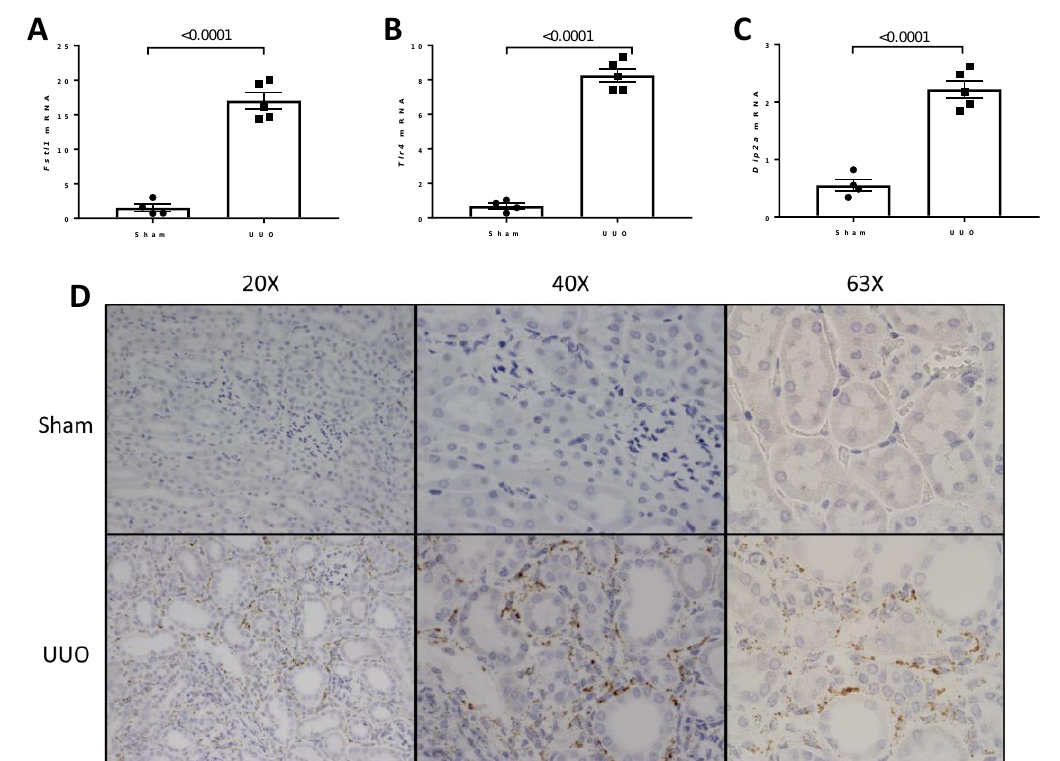
Figure 19. Fstl1 expression and localization in UUO. ( A – C ) mRNA levels for Fstl1 and its putative receptors ( Tlr4 and Dip2a ) were determined by quantitative polymerase chain reaction in kidneys of C57B6 mice (sham n = 4, UUO n = 5). Values are the mean ± SEM (black bars). P values were determined by Student’s t test, and significance was defined as a p value of < 0.05. ( D ) Light microscopic images at three magnifications of RNASCOPE ® Fstl1 localization in sham-operated mice (upper three panels) and mice subjected to UUO for 7 days (lower three panels).